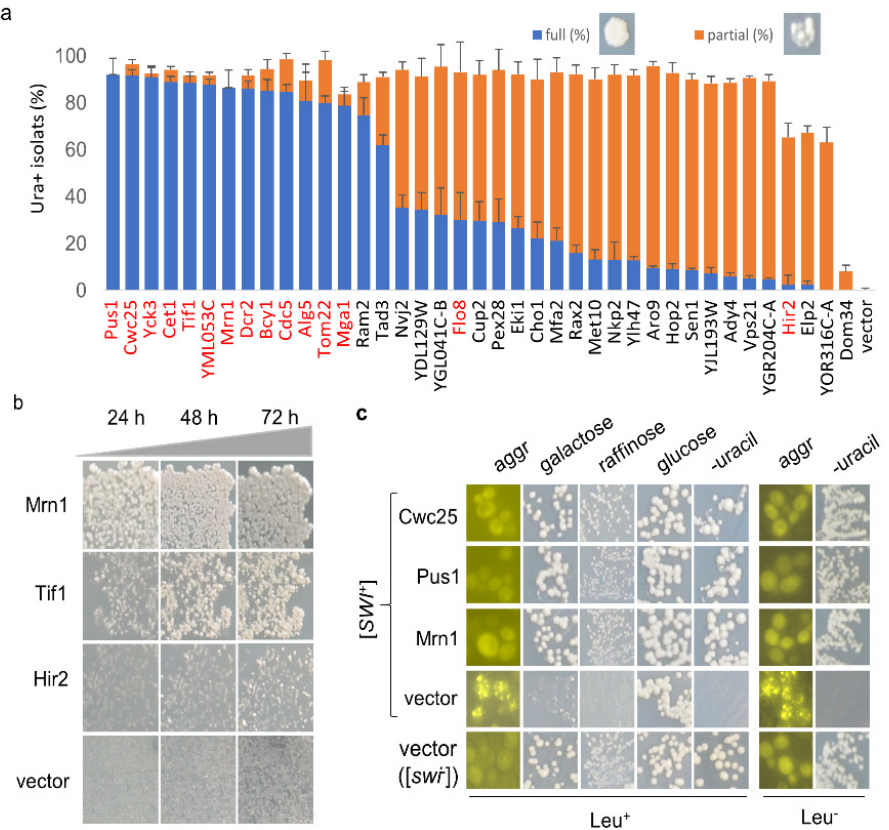
Figure 2. ( a ) Representative hits were quantified for their suppression efficiencies against [ SWI + ]. The [ SWI + ] strain LY770 was transformed with individual hit plasmids or vector (control) in the absence of co-expression of Swi1-QC. Transformants on SC–leu–his were replica-plated onto SC–leu–his–ura plates. After 3.5 days of growth, colonies with a full growth (full (%)) or partial growth (partial (%)) were plotted. Proteins highlighted in red were selected to be the focus of our study; ( b ) Similar to experiments shown in panel a, colonies from SC–leu–his plates were replica-plated onto SC–leu–his–ura plates that were imaged after the indicated hours of incubation. Overall, 15 hits highlighted in red in ( a ) were tested; ( c ) panels of Leu + : Ura + isolates for the 39 hits (listed in ( a )) obtained upon overproduction were assayed for Swi1 aggregation (aggr) and growth on SC plates with the indicated sugars as sole carbon source or on SC plates lacking uracil (-uracil). About 10-21 Ura + colonies were analyzed for each hit. Panels of Leu - : after spontaneous loss of the overexpression plasmids, Swi1 aggregation and phenotypic suppression of the Ura + isolates were examined again. Note: from panels ( a – c ), all strains also carried the p413GAL1-NQYFP plasmid, which allowed us to conduct an aggregation assay. An empty plasmid (vector) and a non-prion strain ([ swi − ]) were included as controls, and the representative data are shown.